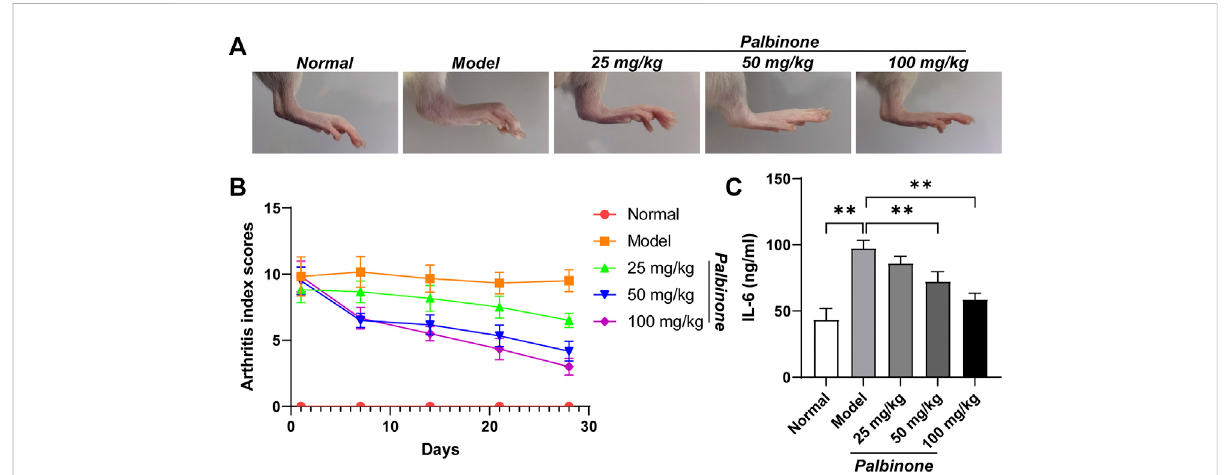
FIGURE 6 The effects of PB on collagen-induced arthritis rats. Rats were given via intradermal injection of 100 µl of emulsion composed of equal parts of CFA and 2 mg/ml of bovine type II collagen at the base of the tail on day 0 to induce the primary immunization, then they were given the boost immunization consisting of 100 µl of the same emulsion on day 7. Rats were oral gavaged with 25, 50, 100 mg/kg PB for 28 days. The images of rat ankle (A) . The arthritis index scores (B) were analyzed on day 1, 7, 14, 21, 28 after PB intervention. The expression of IL-6 (C) was detected by ELISA. Results were mean ± SD for six individual experiments. * p < 0.05, ** p <